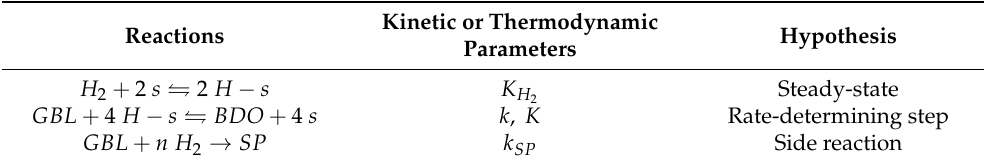
Table 4. Reaction mechanism used to build the kinetic model based on a dissociative adsorption of H 2 : Model 4.